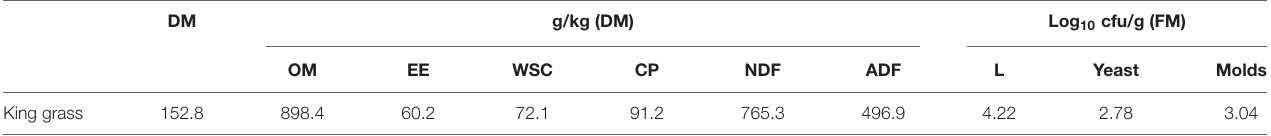
TABLE 1 | Chemical and microbial composition of KG.